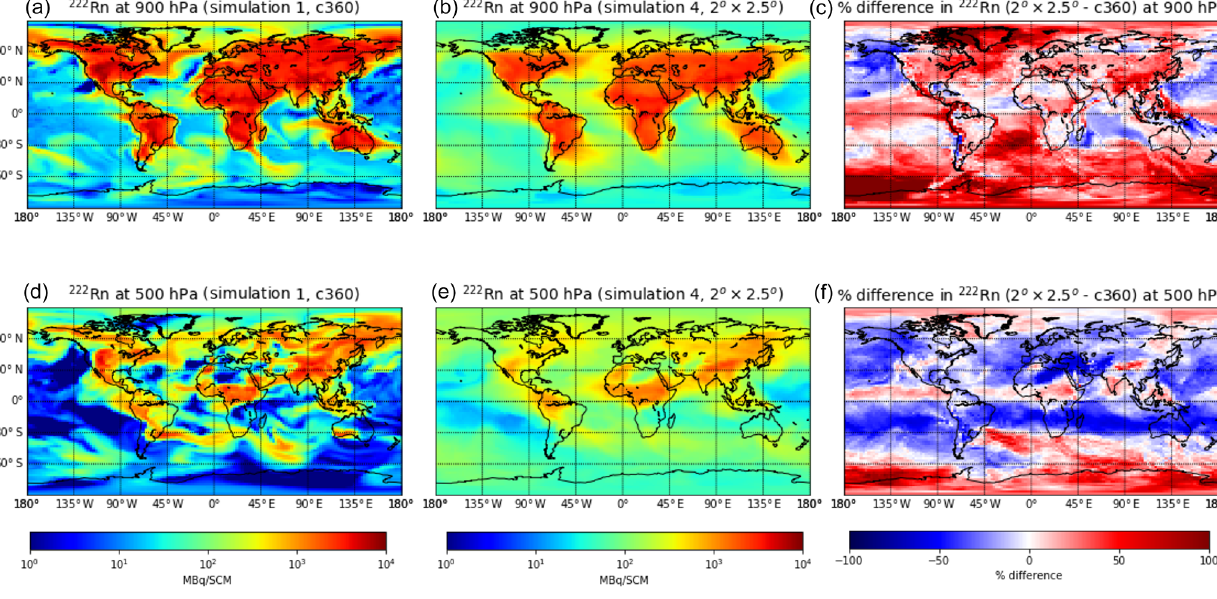
Figure 7. 222 Rn concentrations at 900hPa (a–c) and 500hPa (d–f) from the reference online c360 GEOS-5 simulation (simulation 1; a, d ) and off-line 2 ◦ × 2.5 ◦ GEOS-Chem simulation (simulation 4; b, e ). (c, f) The percent difference in 222 Rn concentrations in simulation 4 relative to simulation